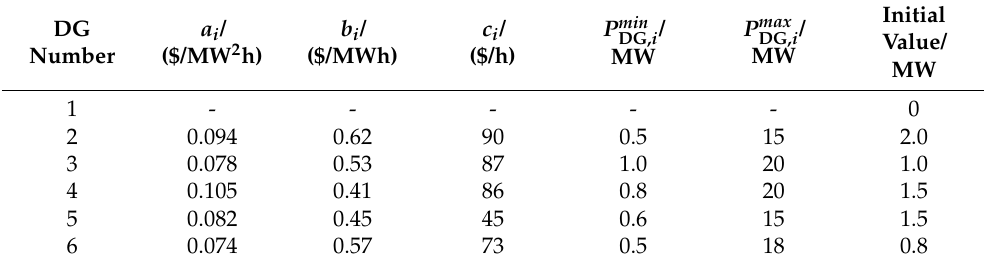
( b ) Figure 3. Incremental costs and DG outputs under ideal communication condition: ( a ) Incremental cost; ( b ) output of DGs. As can be seen from Figure 3, when the load is 28.7 MW, the DG incremental cost converges to the same optimal value λ* = 1.497$/(MWh) from each initial value, the sum of each DG output is balanced with the load in the distribution network; when the load